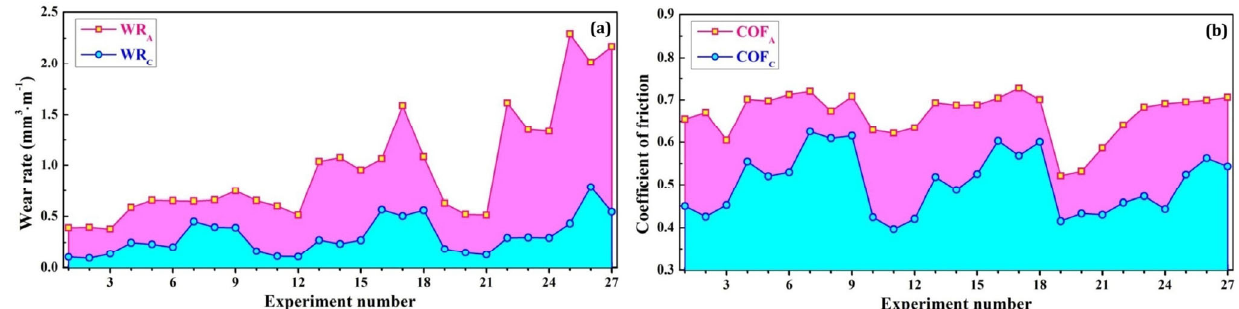
Fig. 2 Graphical presentation comparing wear rates (a) and coefficients of friction (b) between alloy and composite in individual